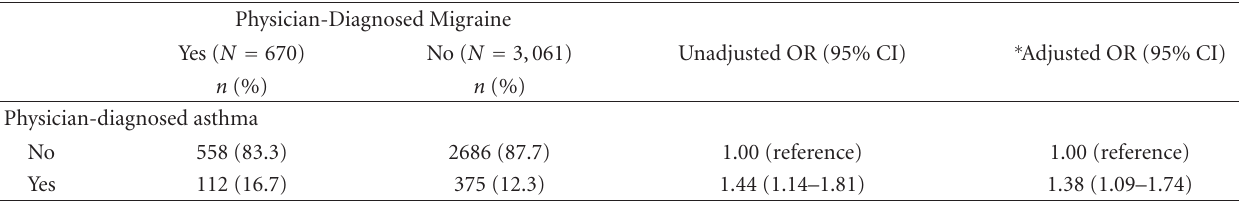
Table 2: Unadjusted and adjusted odds ratios (ORs) and 95% confidence intervals of asthma and migraine comorbidity, Seattle and Tacoma, WA, USA, 1996–2008.